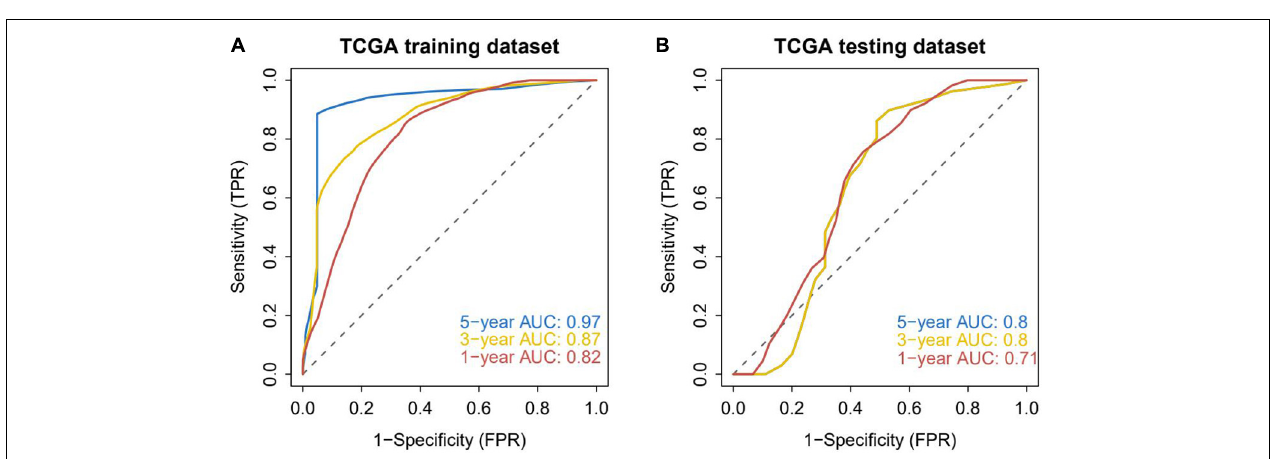
FIGURE 3 | Accuracy analysis of model prediction. (A) ROC analysis of the accuracy of the training set model: the AUC values of 1, 3, and 5 years in the training dataset are all greater than 0.8, indicating that the model has good verification efficiency. (B) ROC analysis of the accuracy of the internal validation set model: the AUC values in the testing dataset for 1, 3, and 5 years are all greater than 0.7, indicating that the model has good validation efficiency.